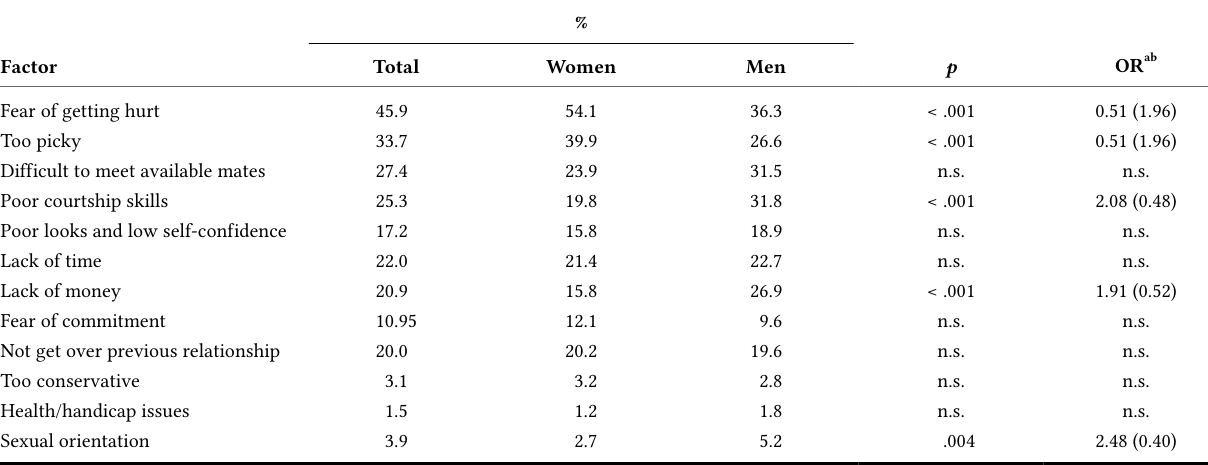
The Percentage of Participants Facing Above Average or Severe Difficulties in Each